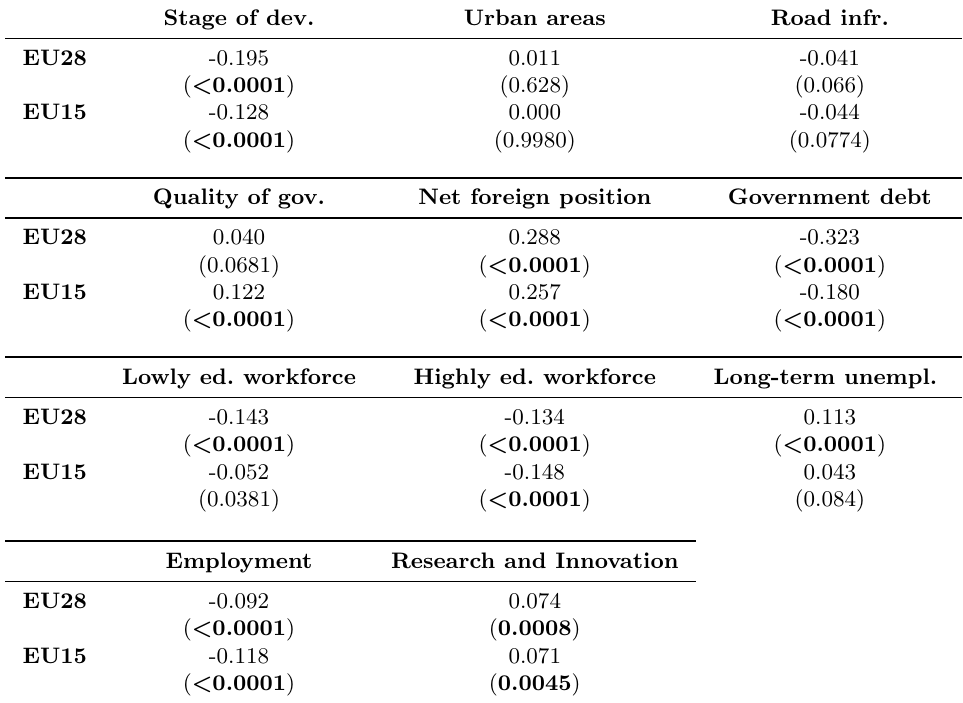
Table 3: Partial correlation coefficients between real GVA growth rate and its explanatory factors ( p -values in